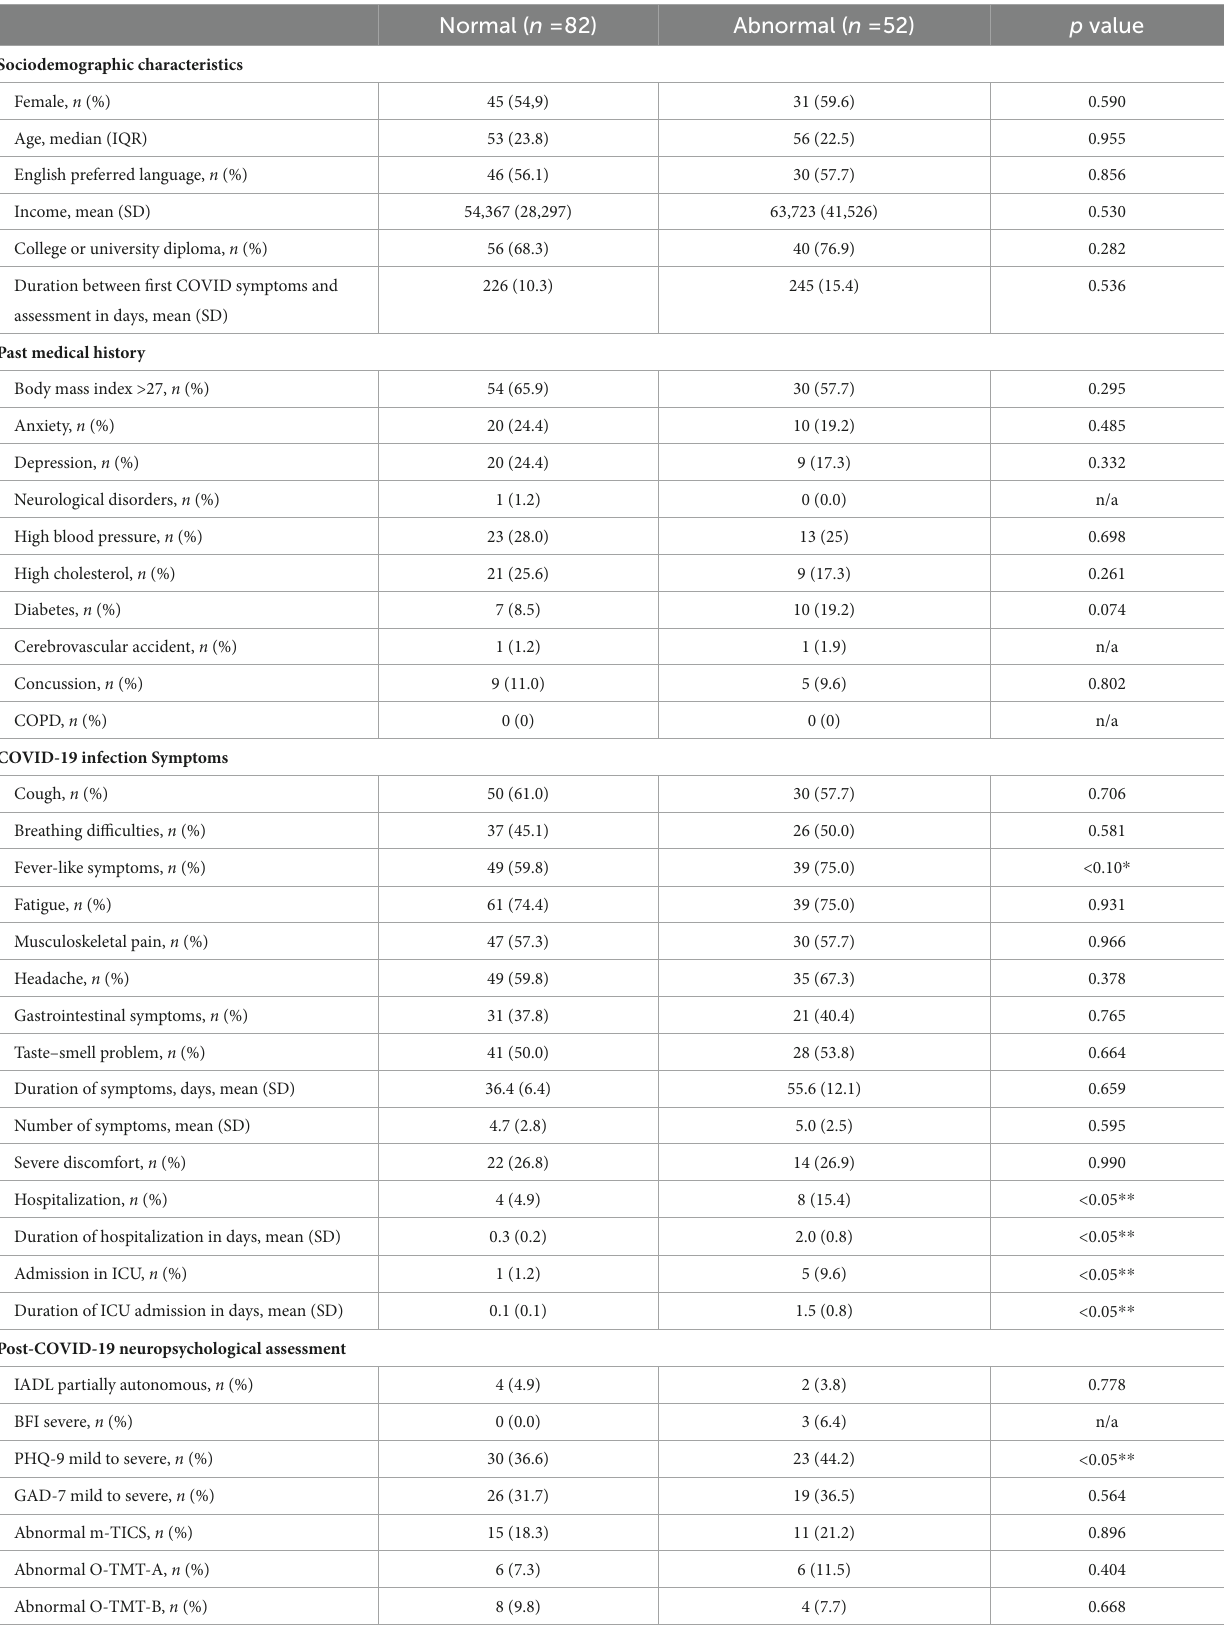
TABLE 6 Comparison of normal and pathologic Hayling and Brixton’s test groups. Normal ( n = 82) Abnormal ( n = 52) p